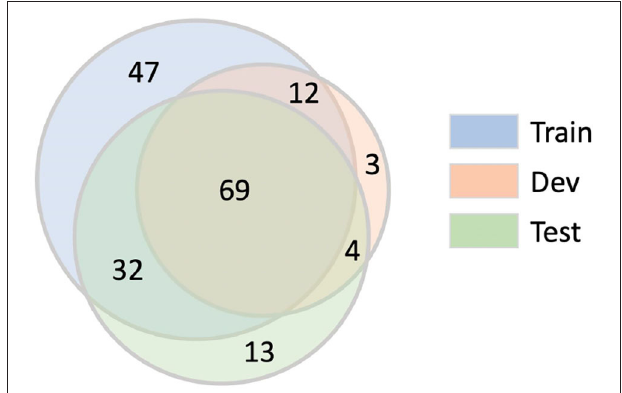
FIGURE 16 | Number of unique source patents in training, development, and test set. Each number represents the number of unique source patents within the sector partitioned by the gray circle boundaries.